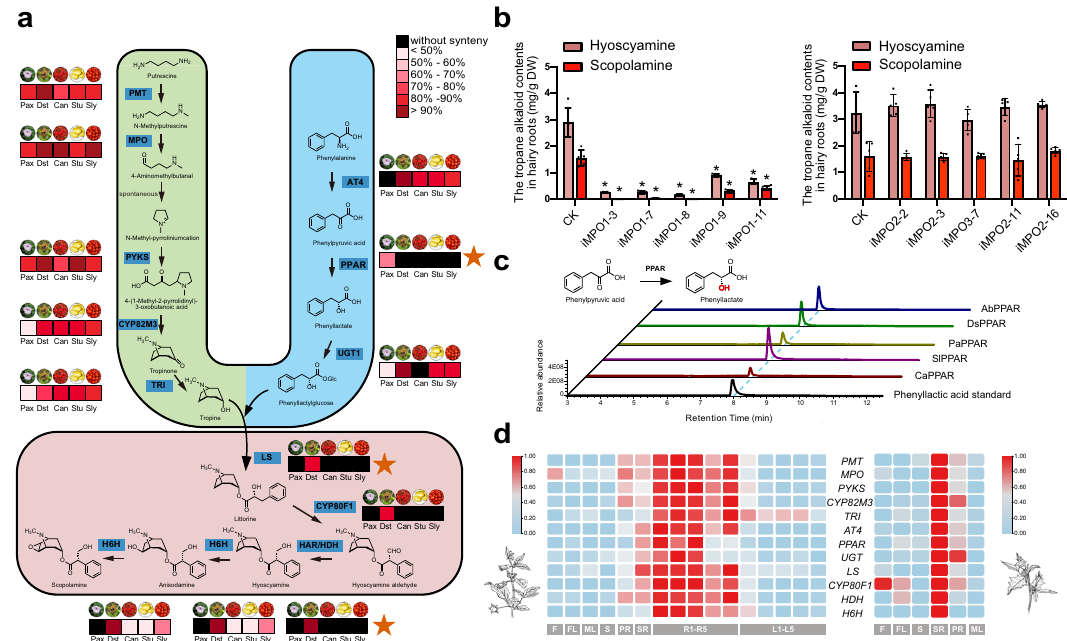
Fig. 3 | Biosynthetic pathway of medicinal tropane alkaloids (mTAs). a Schematic representation of the medicinal tropane alkaloid biosynthetic path- way. Light green represents module I, including PMT putrescine N -methyl- transferase, MPO N -methylputrescine oxidase, PYKS type III polyketide synthase, CYP82M3tropinonesynthase,andTRItropinonereductaseI.Lightbluerepresents module II, including AT4 aromatic amino acid aminotransferase 4, PPAR phe- nylpyruvic acid reductase, and UGT1 phenyllactate UDP-glycosyltransferase. Light red represents module III, including LS littorine synthase, CYP80F1 littorine mutase,HDHhyoscyaminedehydrogenase,andH6Hhyoscyamine6 β -hydroxylase. Pax, P. axillaris ; Dst, D. stramonium ; Can, C. annuum ; Stu, S. tubersoum ; Sly, S . lycopersicum . b The functional characterization of MPOs from A . belladonna by RNAinterferenceinhairyroots.Left,thehyoscyamineandscopolaminecontentsin AbMPO1-RNAi root cultures. Right, the hyoscyamine and scopolamine contents in AbMPO2-RNAi root cultures. CK, control root cultures. iMPO1, hairy root cultures with AbMPO1 RNAi.iMPO2,hairyrootcultureswith AbMPO2 RNAi.DW,dryweight. The data are presented as means values +/ − s.d. ( n =5 biologically independent samples).*,representsasigni fi cantdifferencefromcontrolline(CK)atthelevelsof